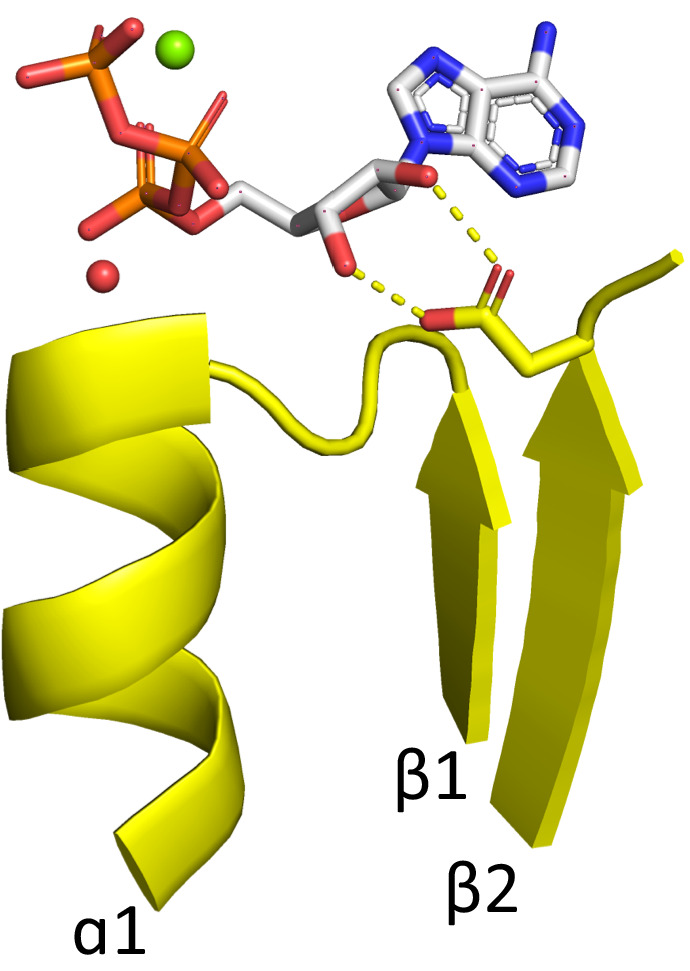
Rossmann domain binding ATP in the canonical binding mode.The phosphate binding loop of ECOD domain e3h5nA5, a Rossmann domain from the ECOD F-group 2003.1.9.15, binds the nucleotide ATP in a largely canonical fashion, including the bidentate interaction between the β2-Asp and the ribose hydroxyls (see Main Text). The conserved water characteristic of the Rossmann fold is shown as a red sphere. An Mg2+ cation is shown as a green sphere. Other F-groups with canonical binding of an NTP include 2003.1.9.10 and 2003.1.4.3.